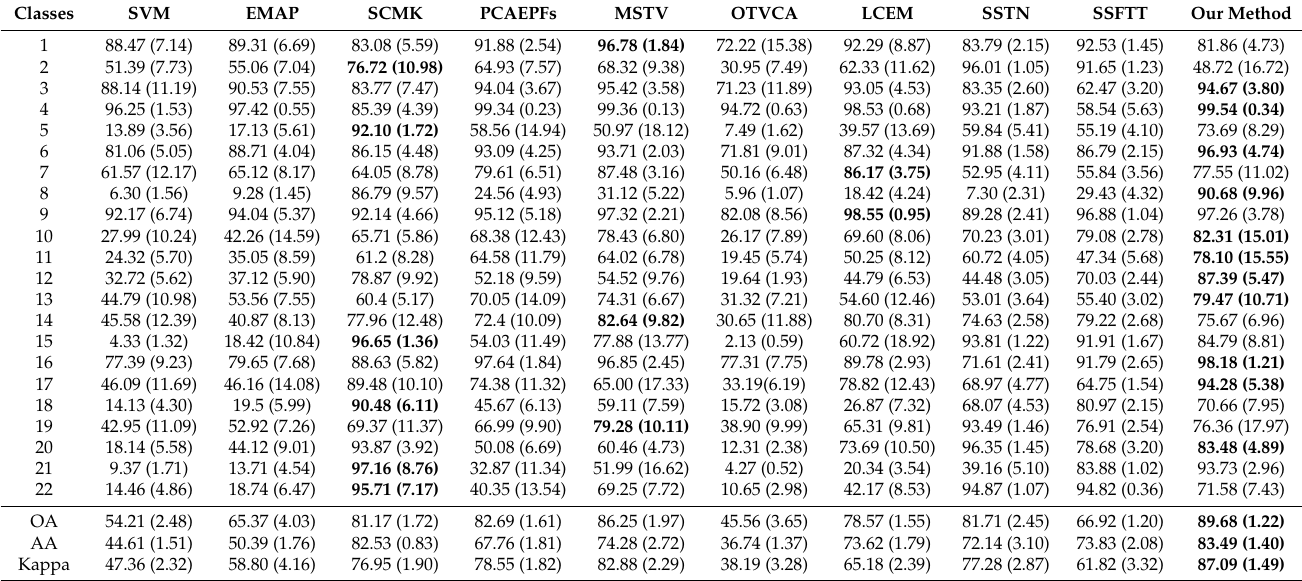
Table 3. Classification accuracies of different classification approaches on the Honghu